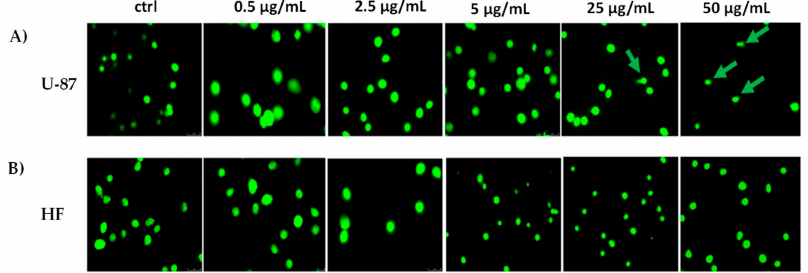
Figure 7. Representative images of U-87 and HF cells treated with di ff erent LnHS doses and subjected to the comet assay (panels A and B respectively). ctrl: untreated cells; green arrows indicate comets with a tail. Experiments were performed in